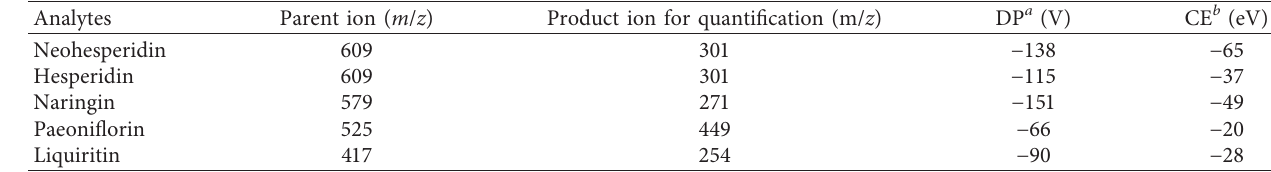
Table 3: Main analytical parameters of all analytes.